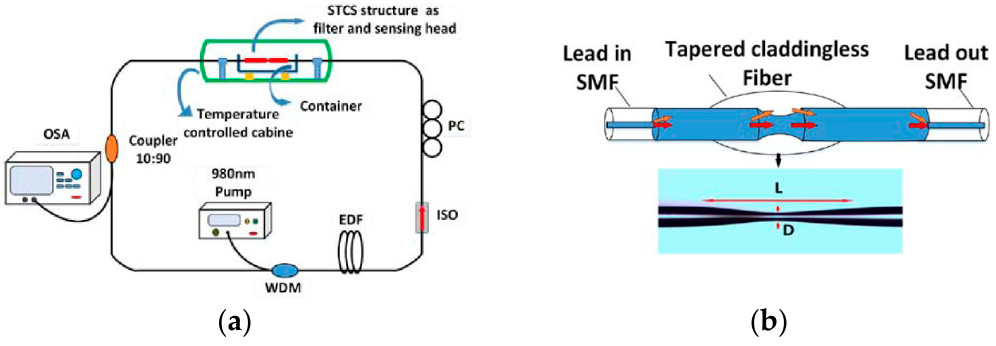
Figure 3. ( a ) Experimental set up of the laser sensing system based on single-mode-tapered claddingless-single-mode (STCS); ( b ) Schematic configuration of STCS fiber structure.